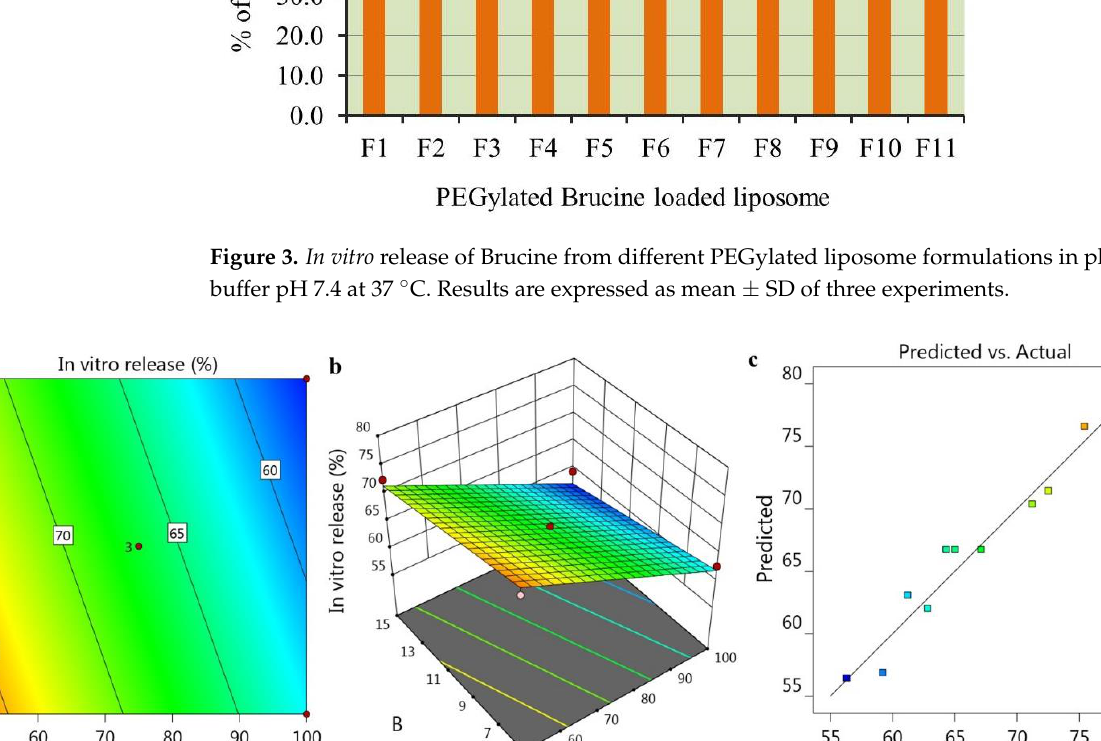
Figure 3. In vitro release of Brucine from different PEGylated liposome formulations in phosphate buffer pH 7.4 at 37 °C. Results are expressed as mean ± SD of three experiments.